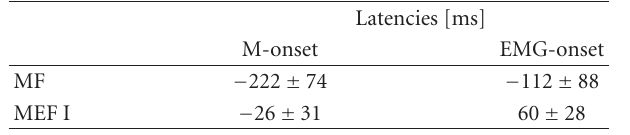
Table 2: Mean latencies across the subject’s motor fields (MF) and Motor evoked fields I (MEF I) in movement onset (M-onset) and EMG-onset per wrist flexion and extension (mean ± standard